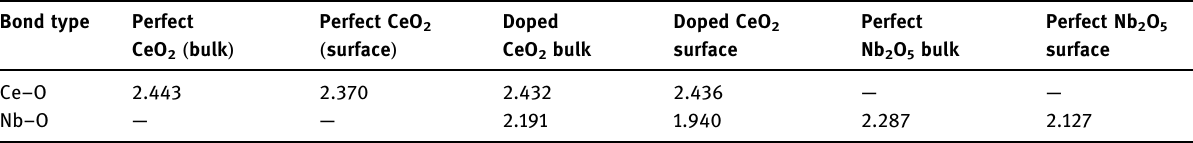
Table 5: Bond distance ( Å ) of the optimized structures Bond type